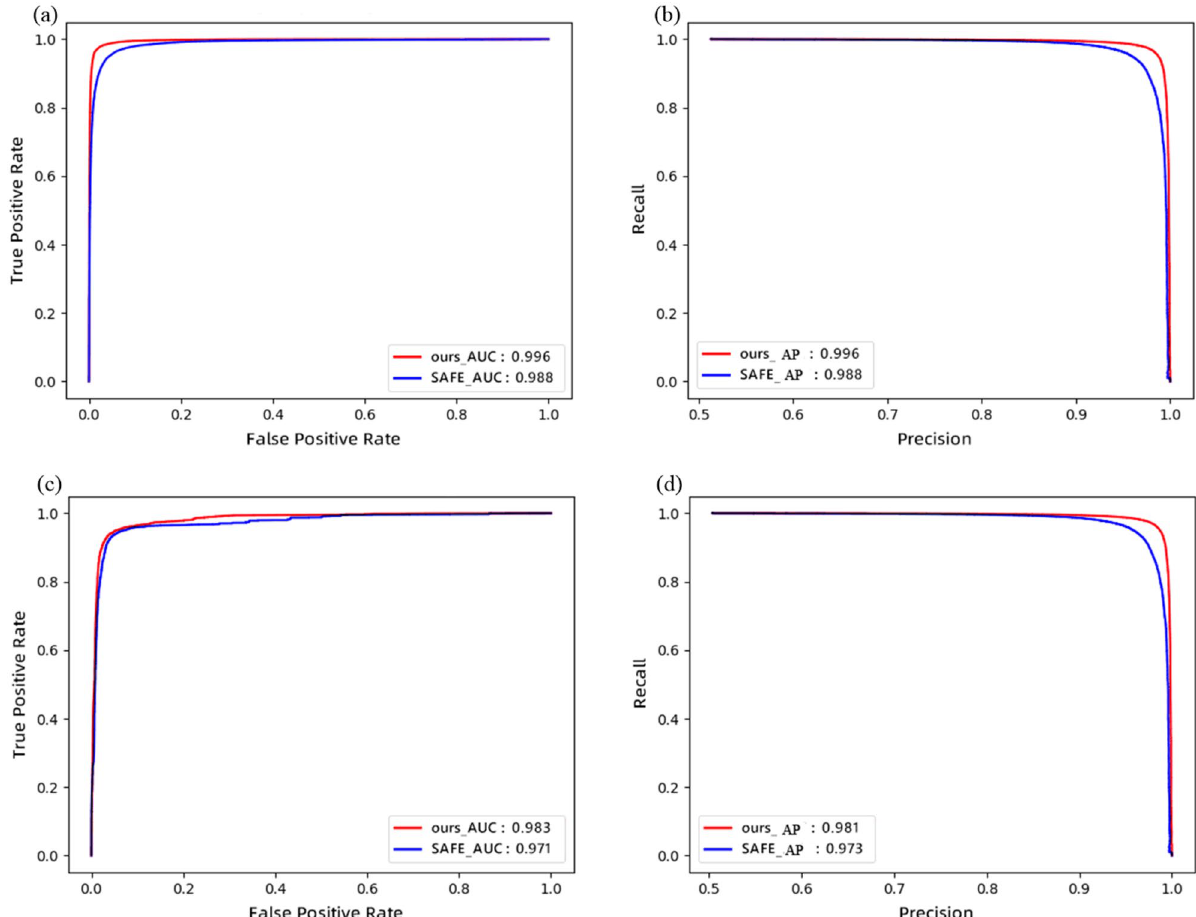
Figure 5. Performance comparison on the test set. ( a ) ROC curves on AMD64multipleCompilers Dataset; ( b ) PR curves on AMD64multipleCompilers Dataset; ( c ) ROC curves on AMD64ARMOpenSSL Dataset; ( d ) PR curves on AMD64ARMOpenSSL